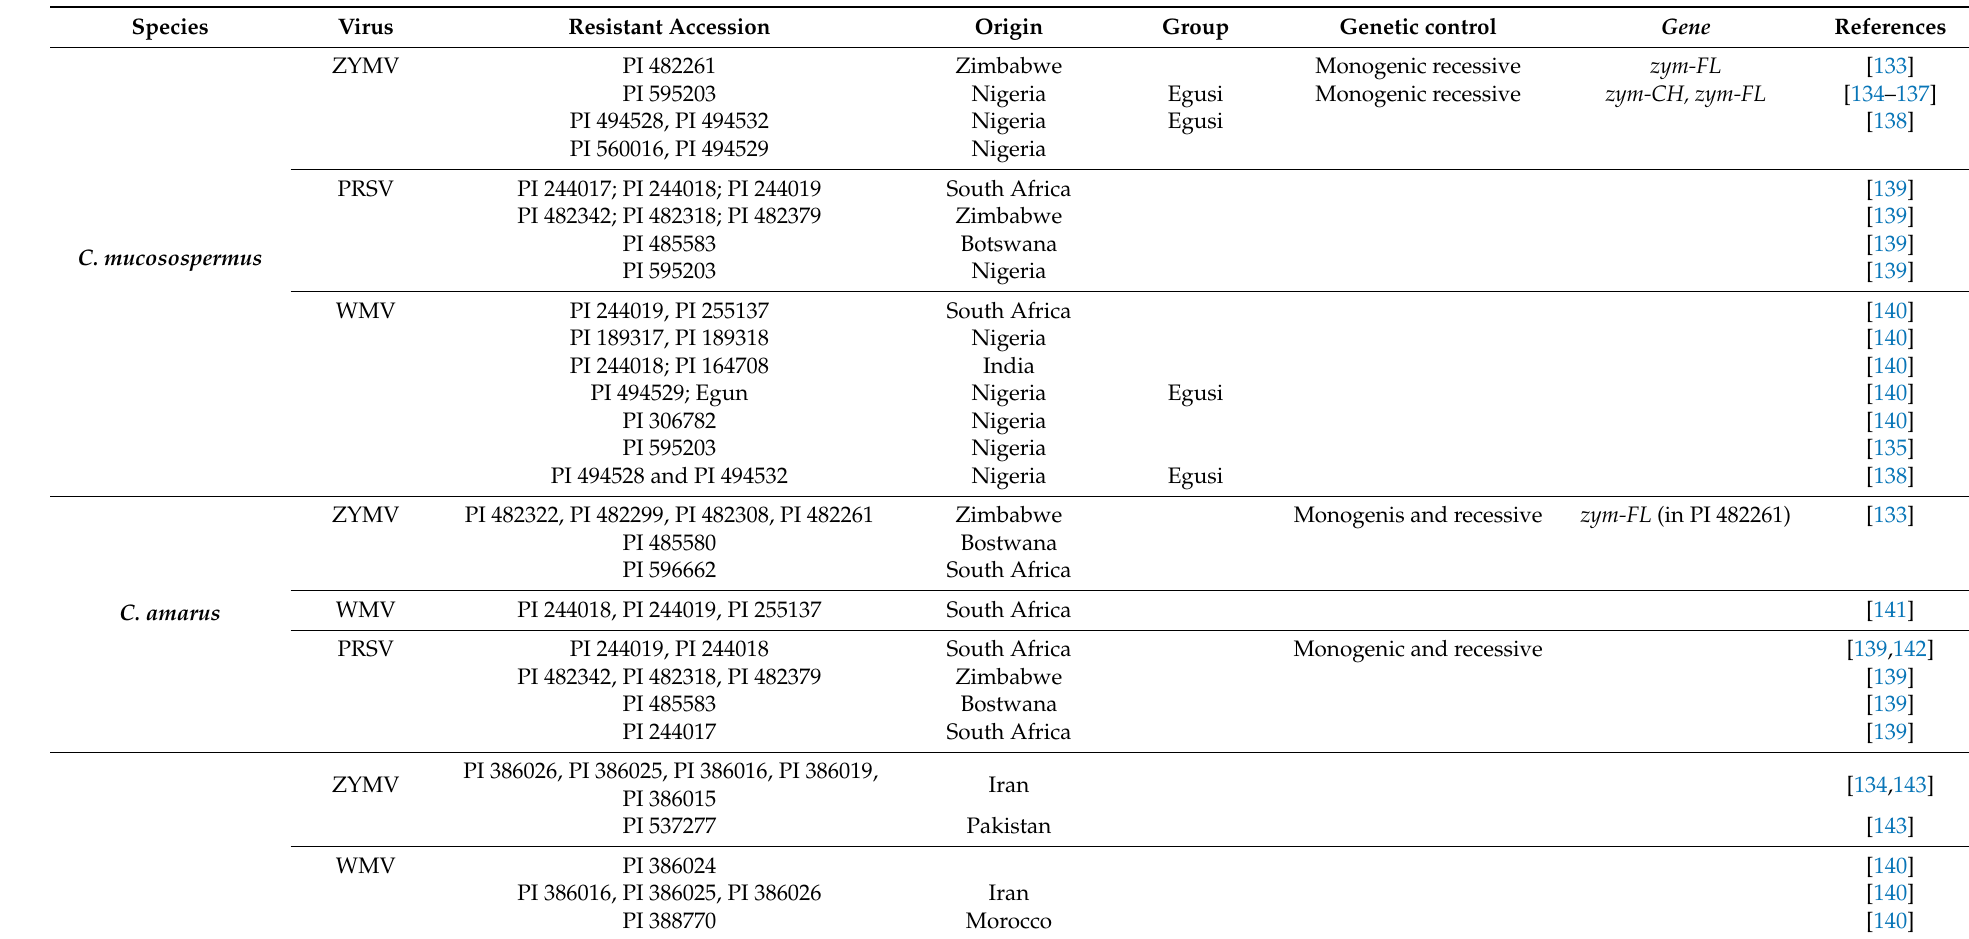
Table 4. Genetic resources for resistance to viruses in Citrullus